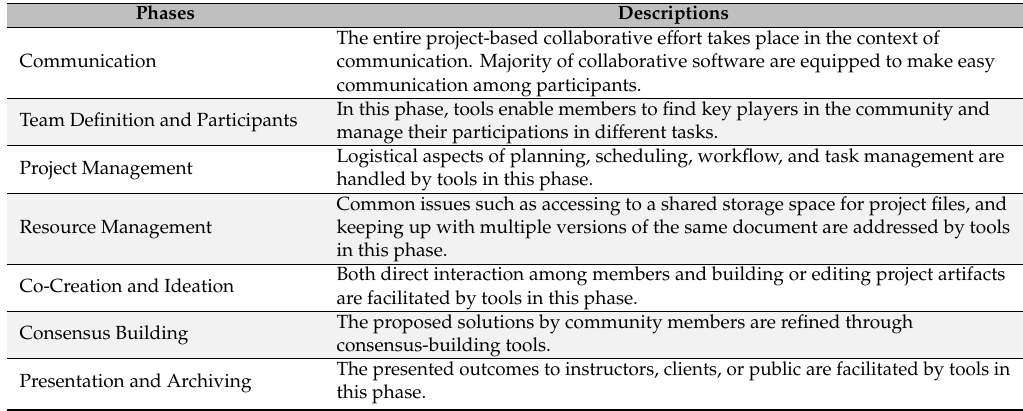
Figure 4. Project-Based Collaborative Learning Model [86]. Table 9. Some partial descriptions for proposed phases in Project-Based Collaborative Learning Model [86]